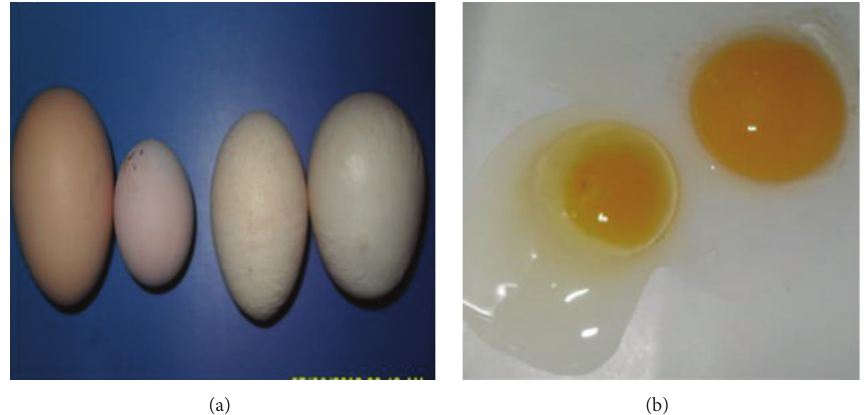
Figure 2: Irregularity in the shape and sizes of eggs from natural IBV infected breeder chickens (a). Watery albumen from IBV infected chicken ((b) left) compared to normal egg ((b) right).